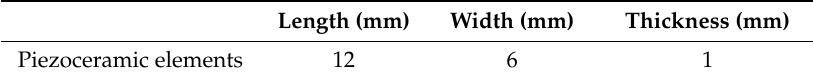
Table 1. Dimension parameters of piezoceramic elements.